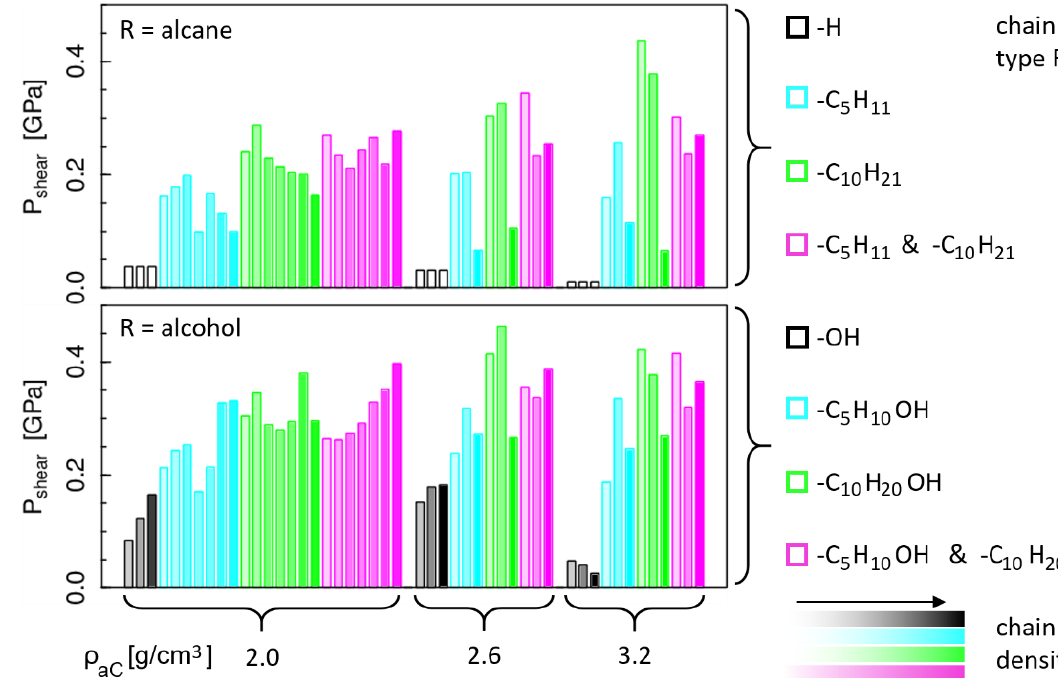
Figure 2. Summary of all shear stress results grouped by a-C density. Bar colors mark different chain